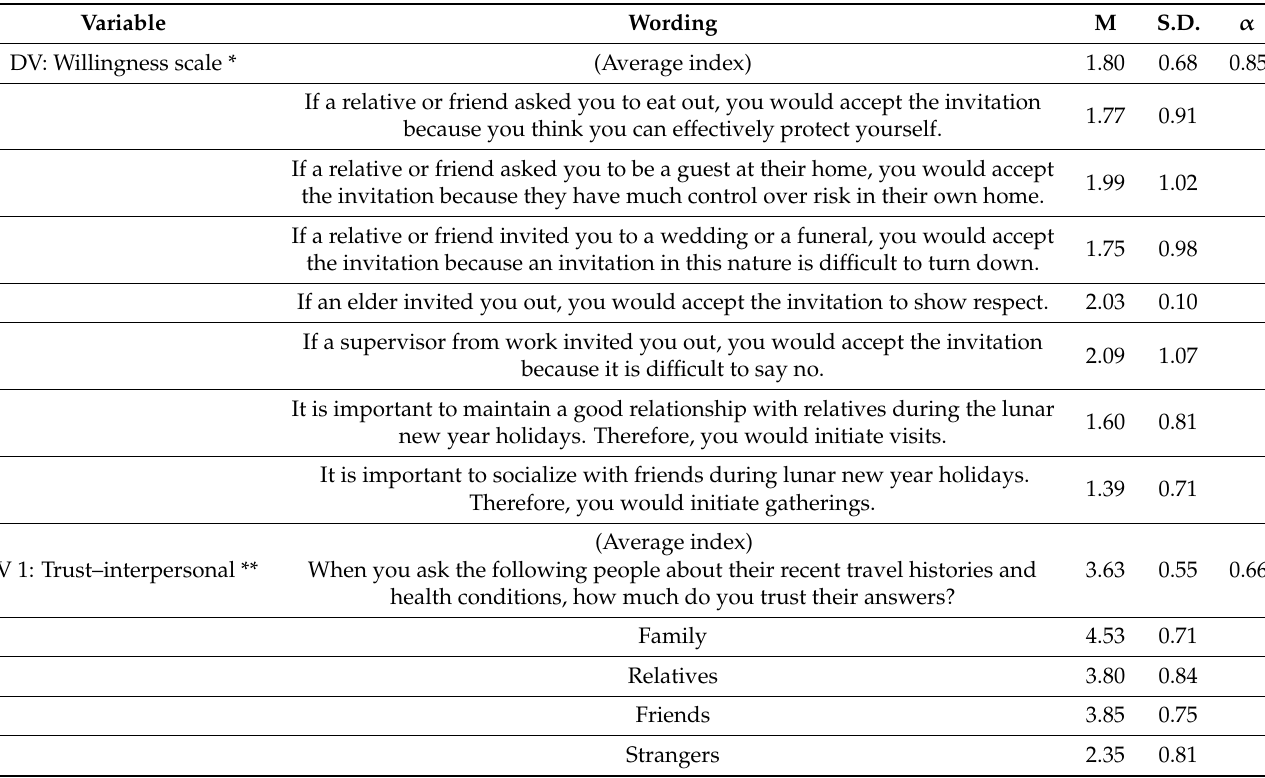
Table 1. A summary of dependent, independent, moderator, and control